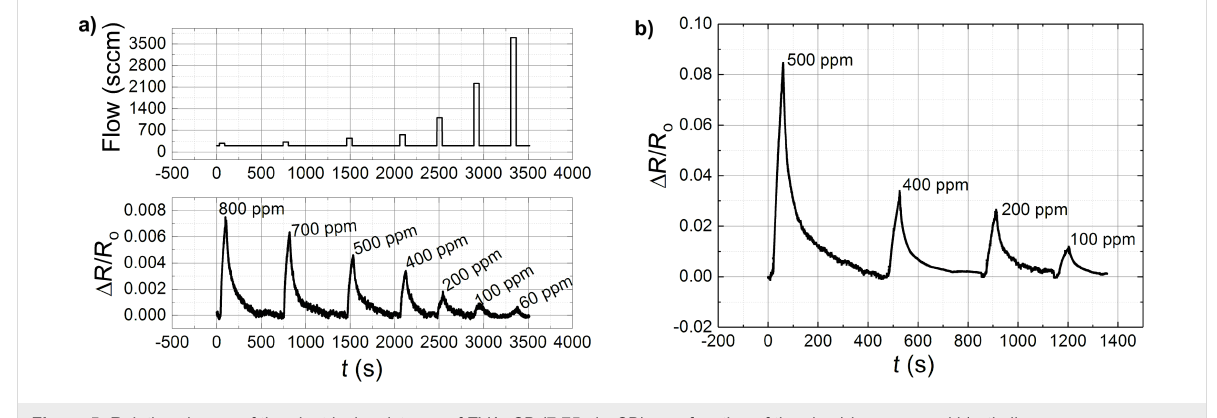
Figure 5: Relative change of the electrical resistance of EVA–CB (7.75 phr CB) as a function of time in a) benzene and b) ethylbenzene vapours (60 s exposure) for various vapour concentrations. Sample thickness is 50 µm.